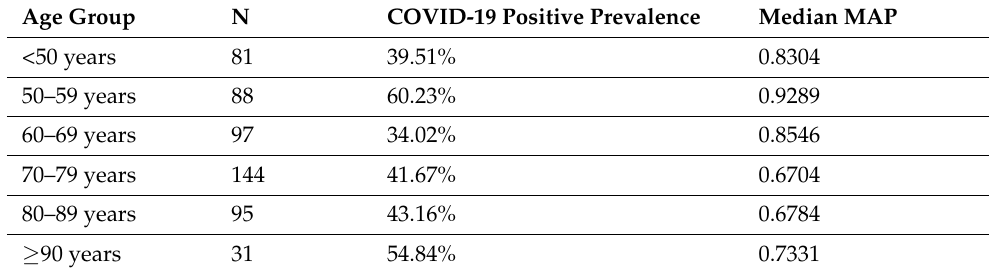
Table 5. MAP performance calculated for each age group.